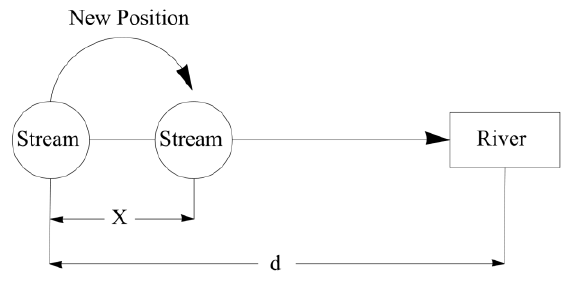
Figure 4. The flow of streams into a specific river.